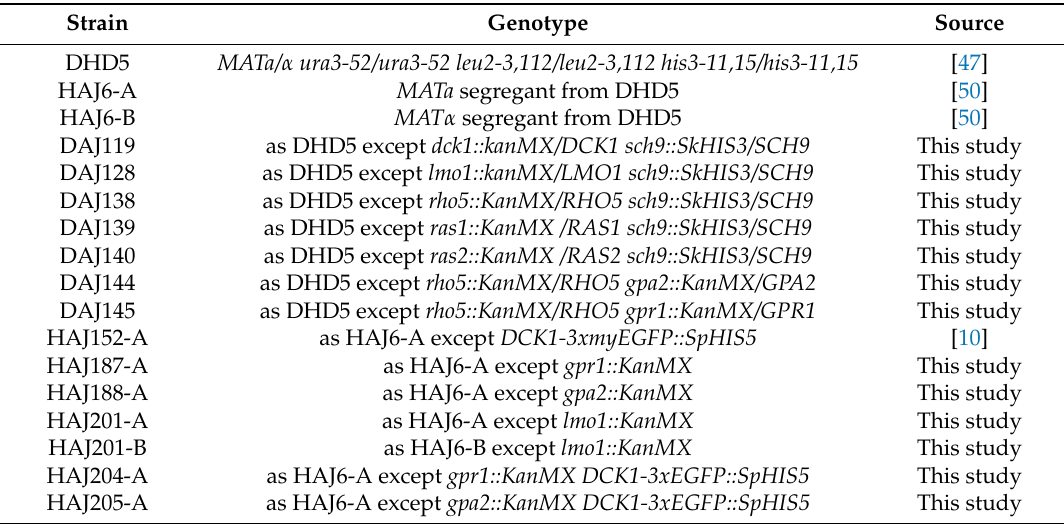
Table 1. Strains used in this